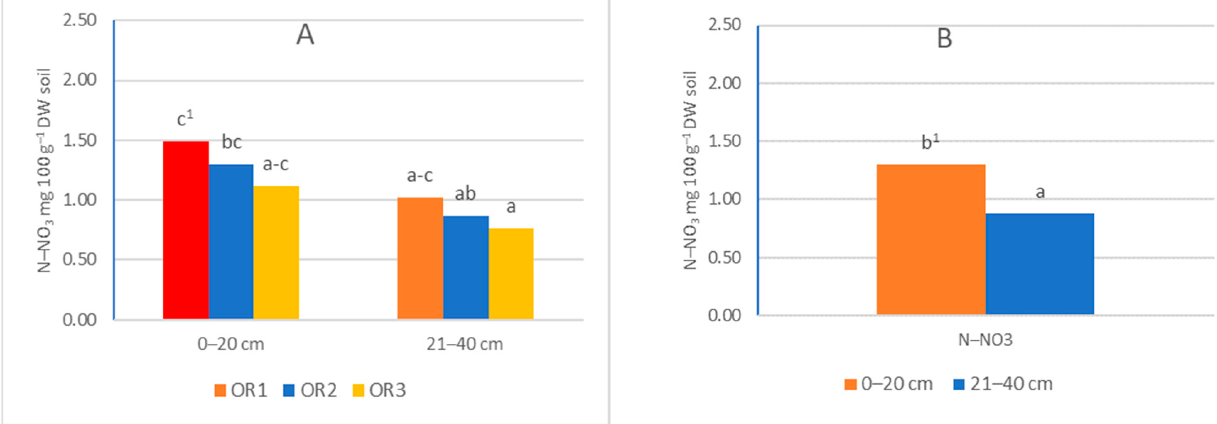
Figure 6. The content of N-NO 3 depending on the ( A )—orchard × soil layer, ( B )—soil layer. 1 means that the same letters are not significantly different at α = 0.05 (Duncan’s test).